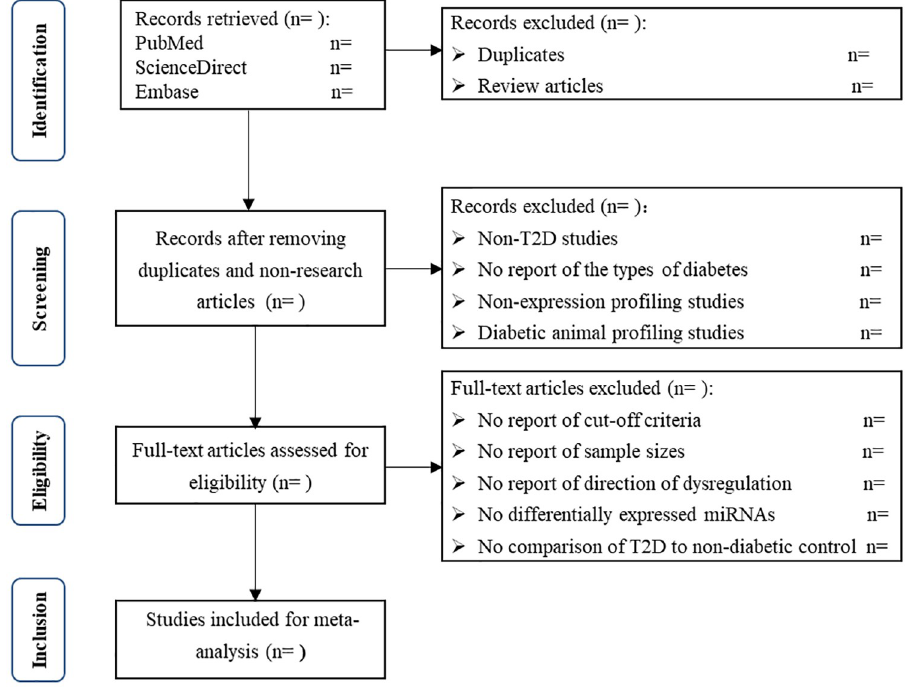
Fig 1. Flow diagram of study